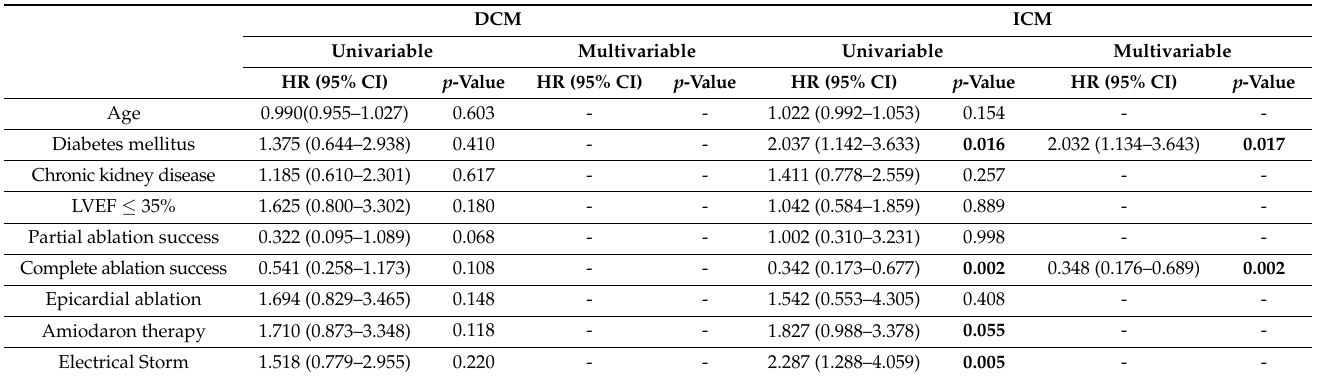
Table 6. Regression model VT Recurrence DCM vs.